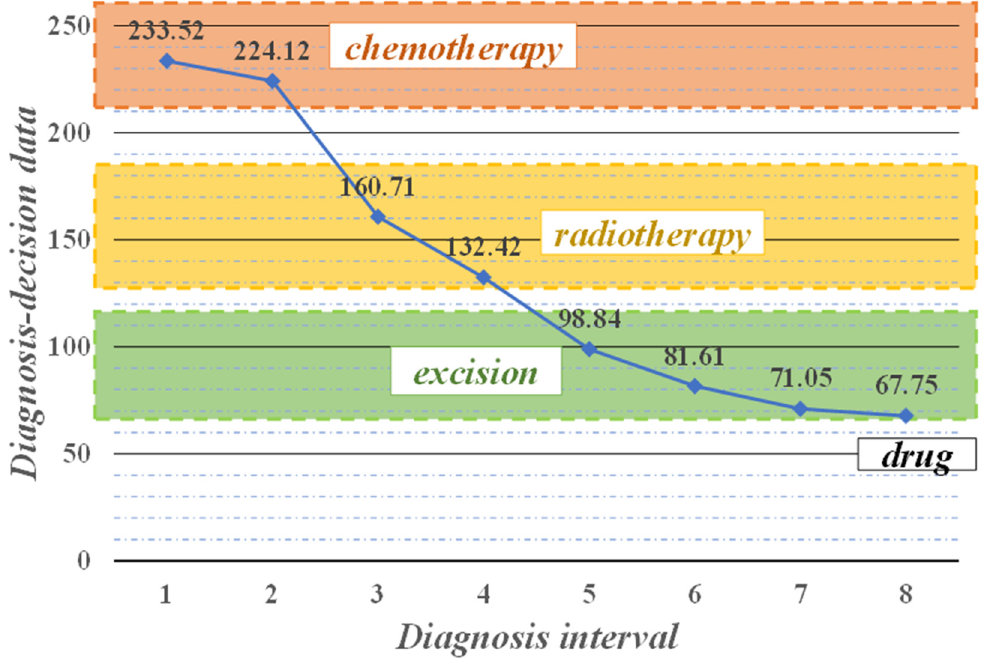
Figure 11. Treatment process of a typical NSCLC